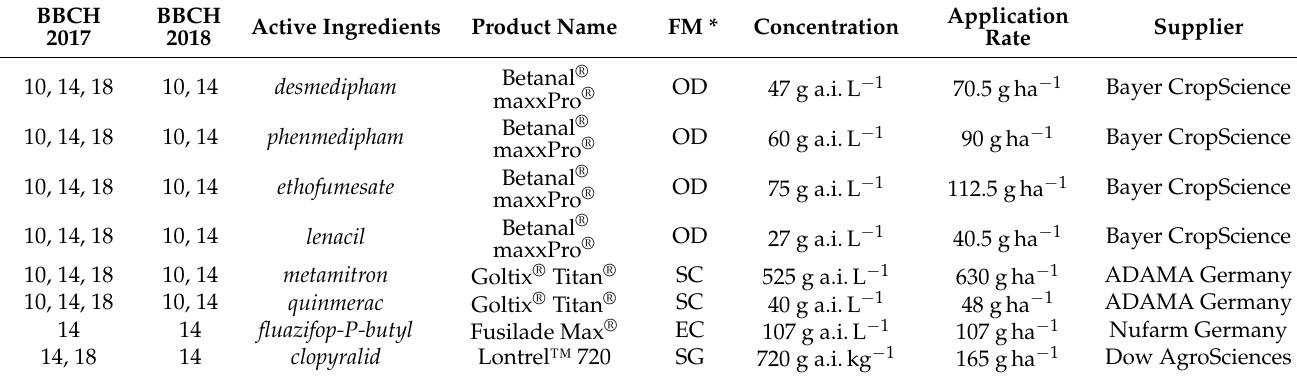
Application Supplier